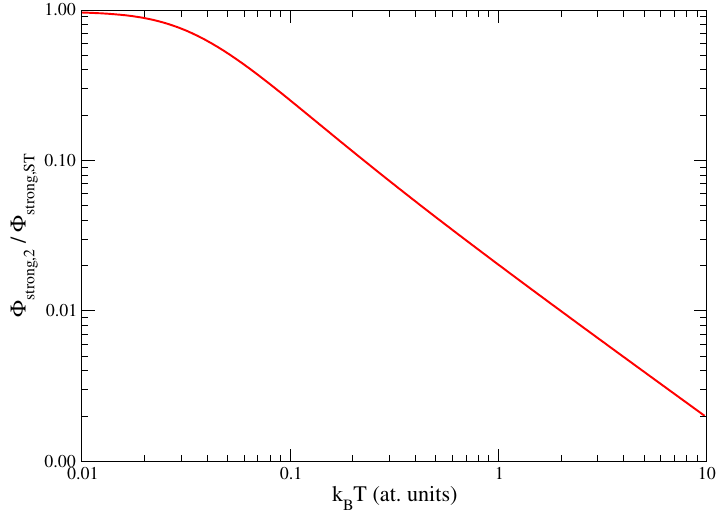
Figure 13. Ratio Φ strong,1 / Φ weak (see Equations (72) and (74)) and Φ strong,2 / Φ weak (see Equations (73) and (74)) as functions of temperature (atomic units) for n α = 3, (cid:96) α = 2, n β = 2, (cid:96) β = 1, and ρ max = n 2 α .